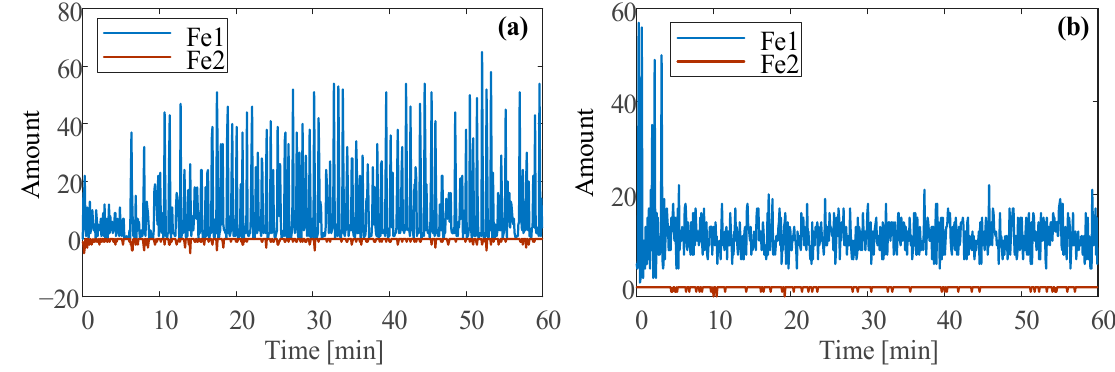
Figure 8. Ferrous particle amount at ( a ) normal and ( b ) unbalance. Under the abrasive wear condition, the amount of the nonferrous particles in the first four size ranges (NonFe1-NonFe4) are considered, as shown in Figure 9. To reproduce the pitting or spall fault of bearings, the nonferrous particle contaminants are added into the bearing during operation. The contact surfaces of the raceways and balls will rapidly be pitted or spalled through abrasive wear. Due to flow rate or adhesion, it is hard to confirm whether the contaminants enter the bearing. By monitoring the size and amount of nonferrous particle contaminants, one can accurately know the time when the contaminants contact the raceways and balls. It can be seen that nonferrous particle contaminants are mainly in the two size ranges of NonFe1 and NonFe3. Through the amount of particles in the NonFe3 size range, around 2 min, 5 min, and 37 min, there are large-size particle contaminants.